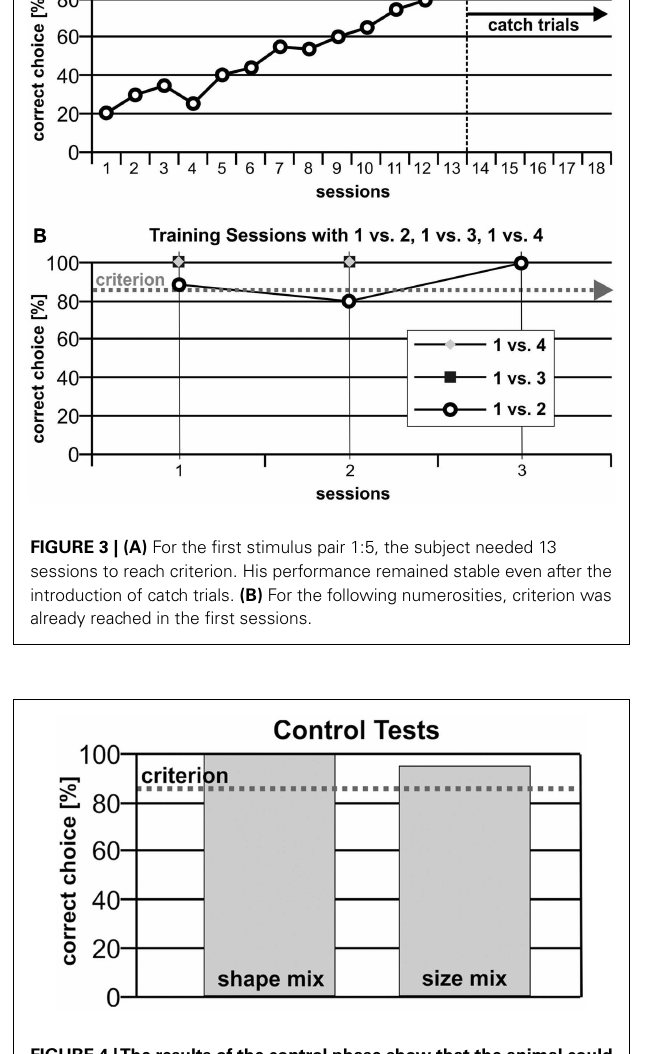
FIGURE 4 |The results of the control phase show that the animal could transfer the learned performance to new and unreinforced stimuli.